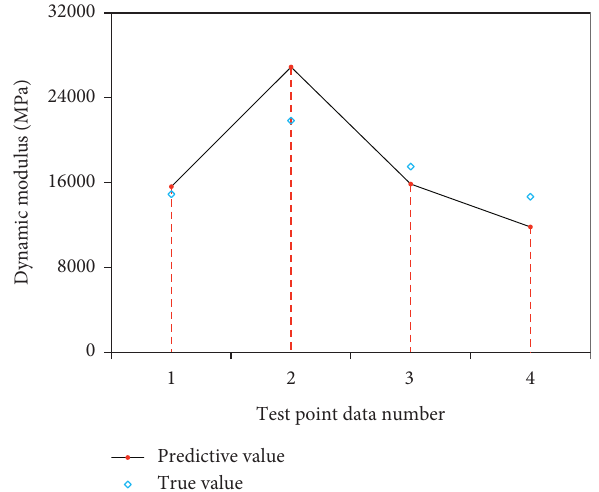
Figure 4: The prediction error of the GRNN model.